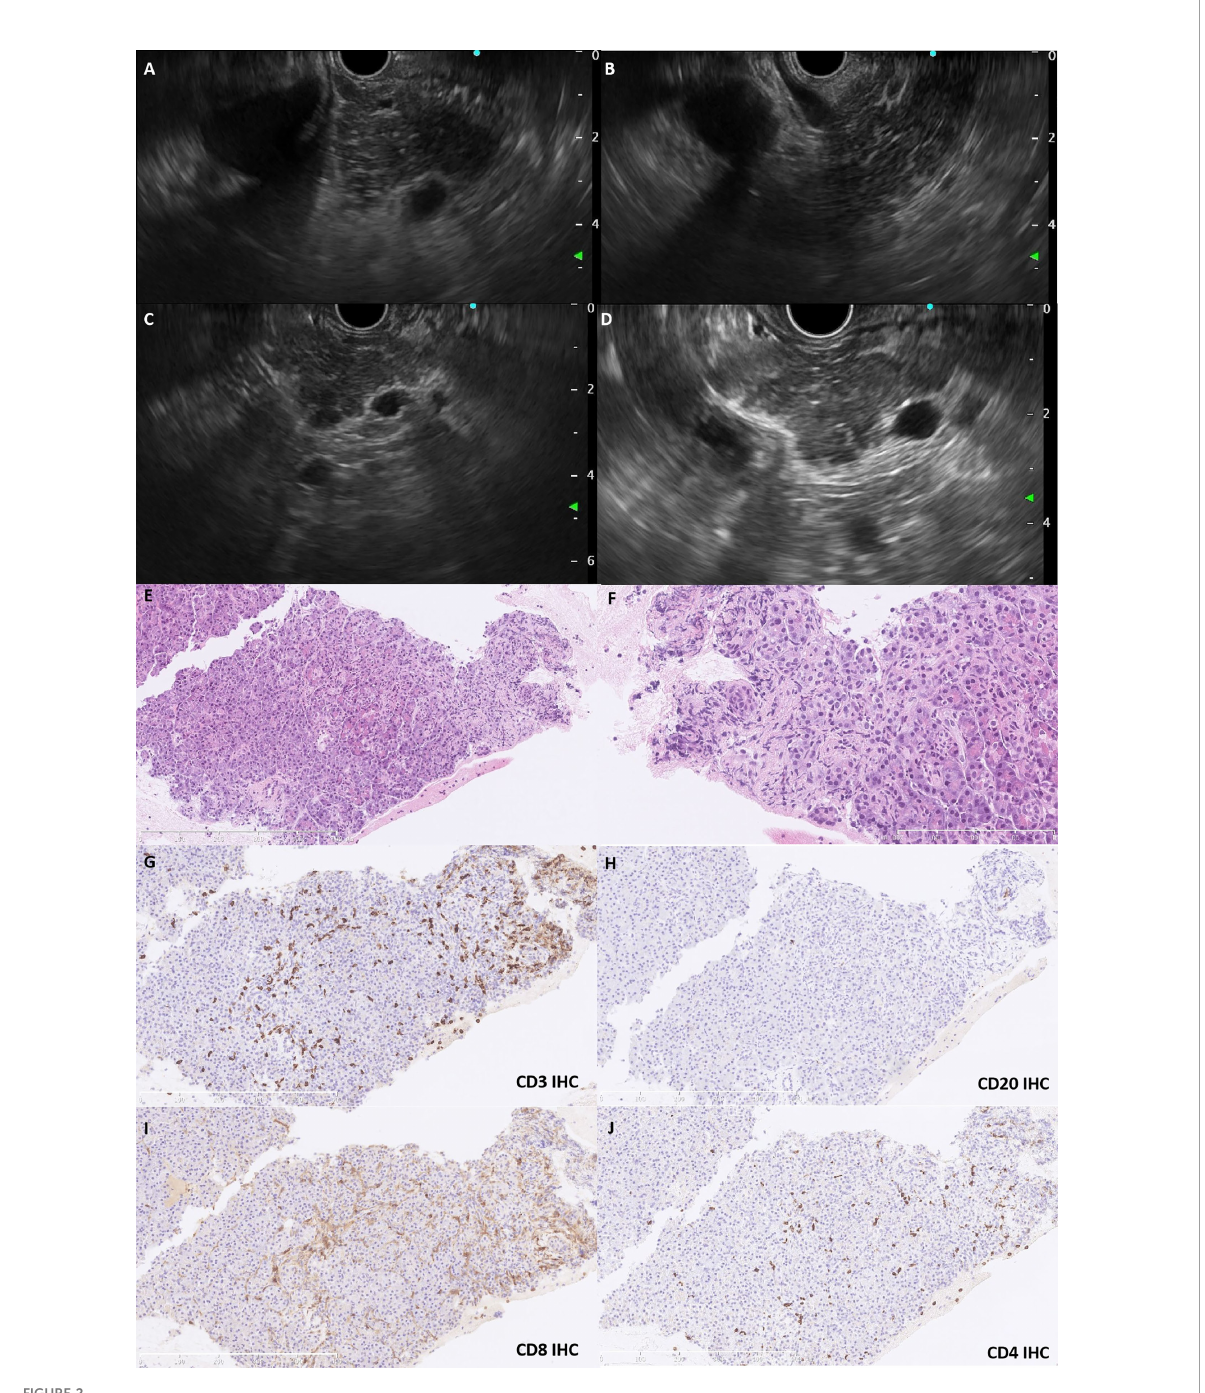
FIGURE 2 The EUS and histopathological features. EUS revealed a slightly swollen pancreas with heterogeneous echoic signals and scattered hyperechoic strips in the parenchyma (A, B) . The pancreatic duct was regular without dilatation, and the pancreatic tail was slightly enlarged without a mass lesion (C, D) . Pancreatic biopsy shows retention of the lobular architecture with focal atrophy of acini in fi ltrated with neutrophils and lymphocytes ( E , HE staining,×150; F , HE staining, ×400). The lymphocytes were predominately T cells ( G , CD3 IHC), although scattered B cells ( H , CD20 IHC) were also present. CD8 + T cells ( I , CD8 IHC) tended to dominate compared with CD4 + counterparts ( J , CD4 IHC). EUS, endoscopic ultrasound; IHC, immunohistochemistry; HE, hematoxylin –